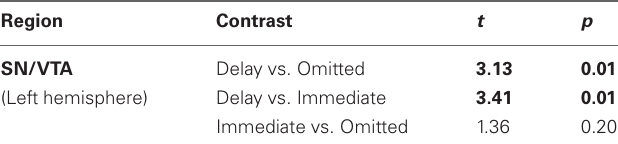
Table 3 | ROI analysis of the